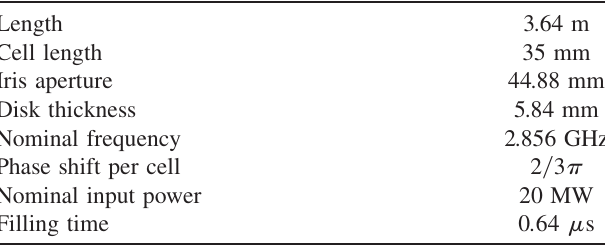
TABLE II. Properties of the TDS at FLASH [2,14].